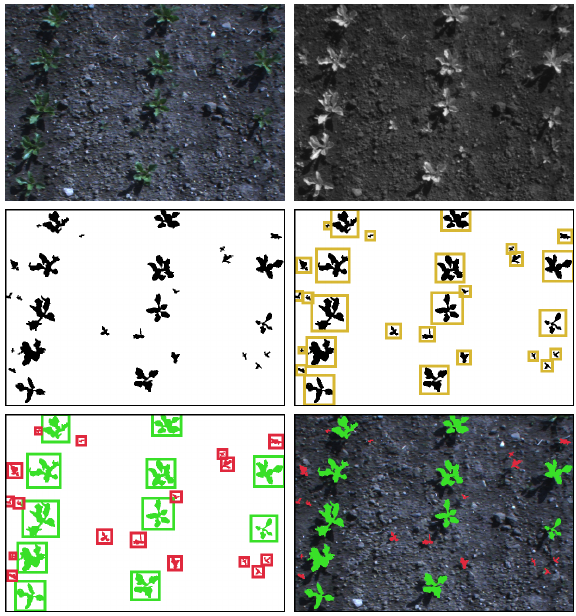
Figure 1. Illustration of our approach. Top: Original RGB and NIR images. Middle: NDVI mask and connected blob segmentation. Bottom: Classified blobs and pixel-wise overlay to original